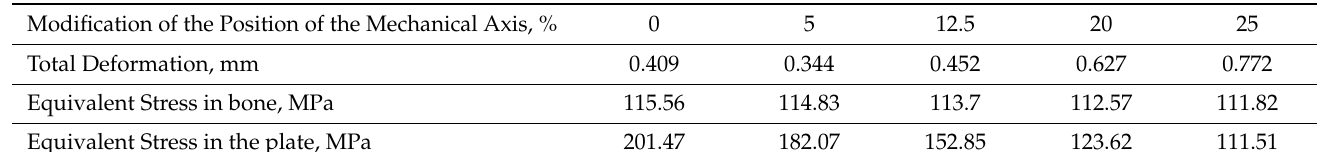
Table 9. Maximum values for deformations, bone stress equivalent, plaque stress equivalent obtained after FEM analysis.